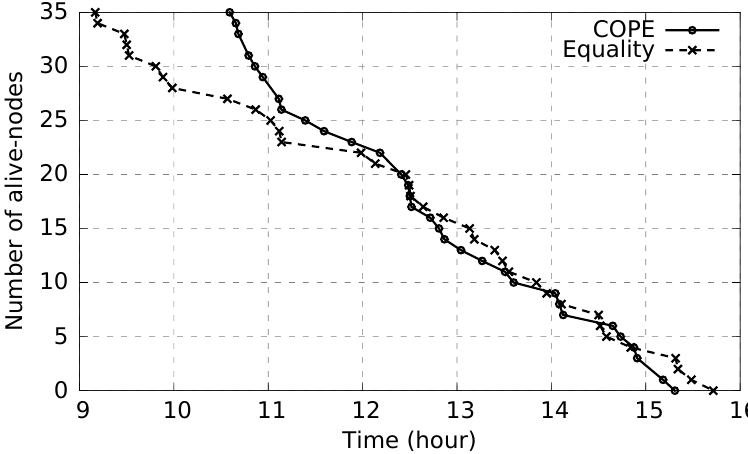
Figure 12. Network node disappearance due to lack of